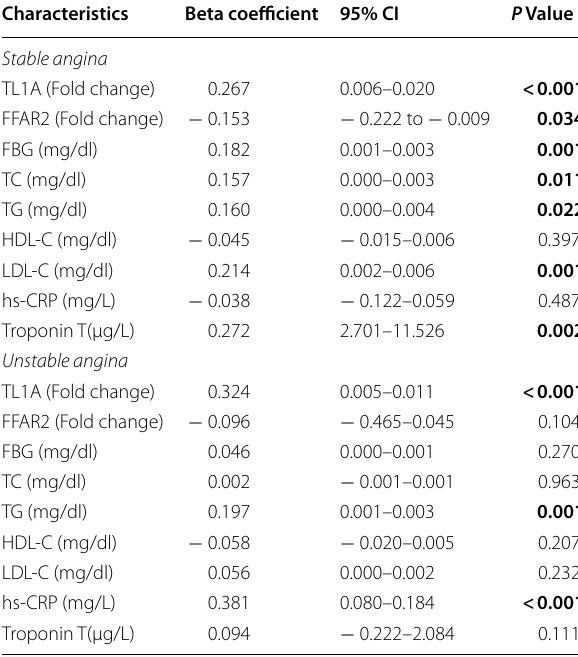
Table 2 Multivariate regression analysis to determine the independent predictors for stable and unstable